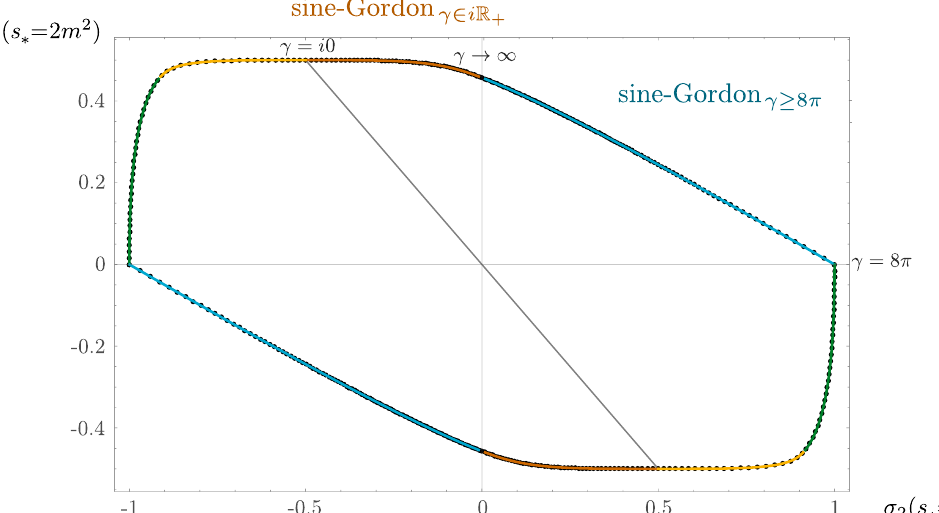
Figure 13 . The O(2) slate. The black dots are numerical data obtained with the dual minimization explained in appendix D for a small frequency w = 1 = 8. The blue/green curves correspond to the analytic solution (E.1) with (cid:13) (cid:21) 8 (cid:25) whereas the orange/yellow ones are obtained with (cid:13) 2 i R + . The blue and green (orange and yellow) sections are related by the map (cid:27) 2 ! (cid:0) (cid:27) 2 (cid:0) 2 (cid:27) 1 , as highlighted by the (cid:27) 2 = (cid:0) (cid:27) 1 line in